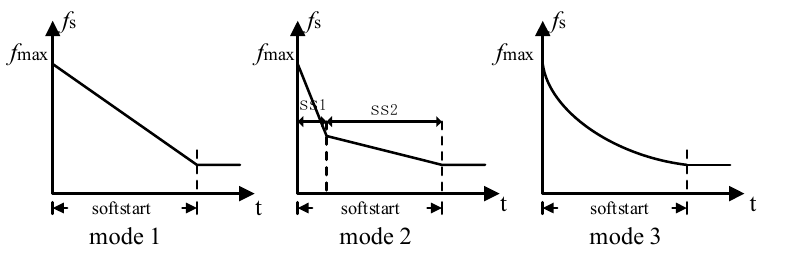
Figure 14. Soft start frequency reduction method.